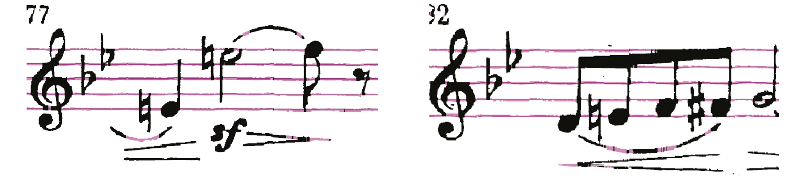
Figure 7: Examples of sta ff lines removal.